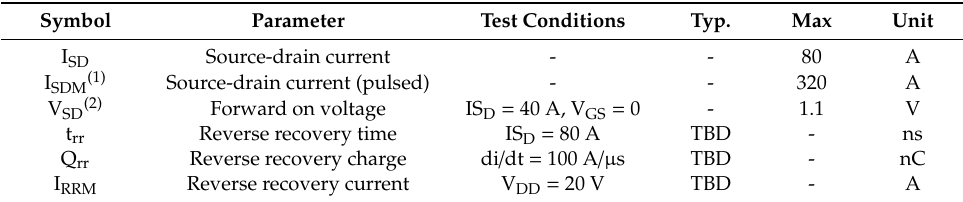
Table A3. Source drain diode STD95N3L